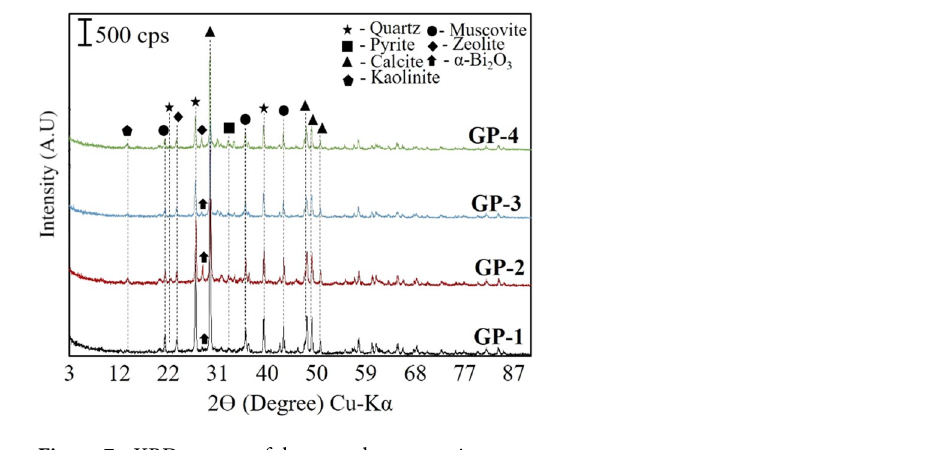
Figure 7. XRD pattern of the geopolymer